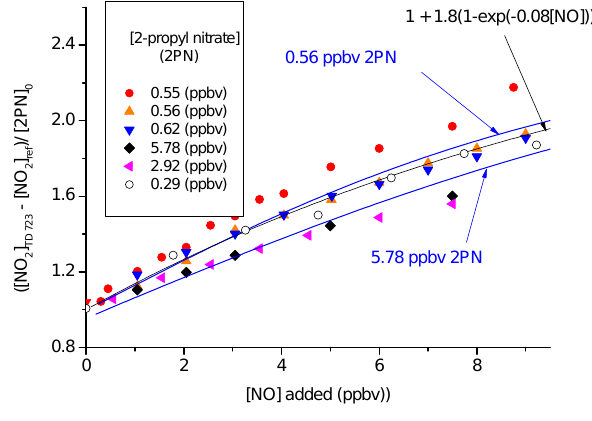
Figure 13. Relative change in difference signal ([NO 2 ] TD723 − [NO 2 ] ref )/ [2PN] 0 ) ) as a function of added NO for six different 2-propyl nitrate (2PN) mixing ratios. [2PN] 0 is the measured mixing ratio of 2-propyl nitrate in the absence of added NO. The sample with 0.62ppbv 2-propyl nitrate also con- tained ∼ 5ppbv of NO 2 . The black line is defined by the expression ([NO 2 ] TD723 − [NO 2 ] ref )/ [2PN] 0 ) = 1 + 1.8 × (1 − exp( − 0.08[NO])), where [NO] is the mixing ratio of NO inppbv. The blue lines show model results with 0.56 and 5.7ppbv 2-propyl nitrate.